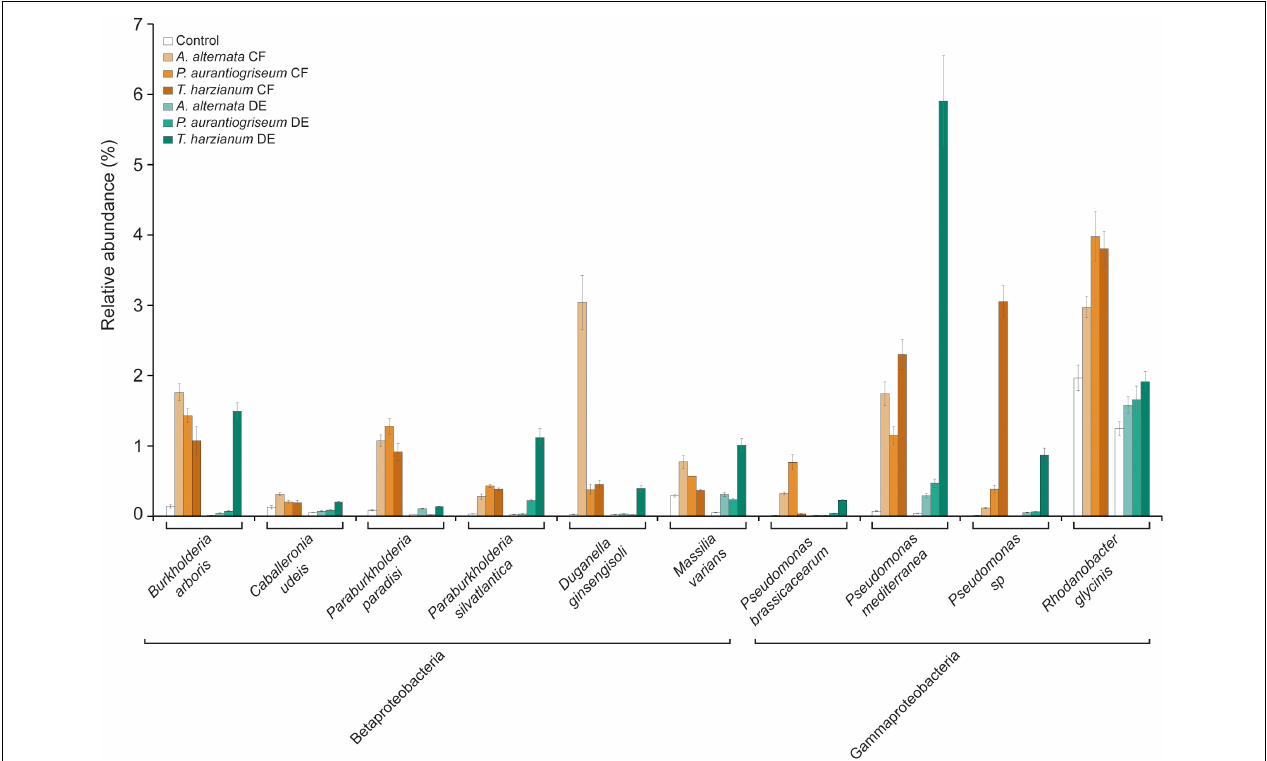
FIGURE 6 | Soil application of fungal CFs and DEs strongly enriches the same beneficial soil bacterial species. The figure shows the relative abundances of bacterial species in soil discussed here that were significantly up-regulated by soil application of fungal CFs (highlighted in brown) and DEs (highlighted in green) according to a Student’s t -test ( P < 0.05). Values represent the mean ± SD. Relative abundances of bacteria in control soils are shown in white bars. Data obtained from Supplementary Table 4